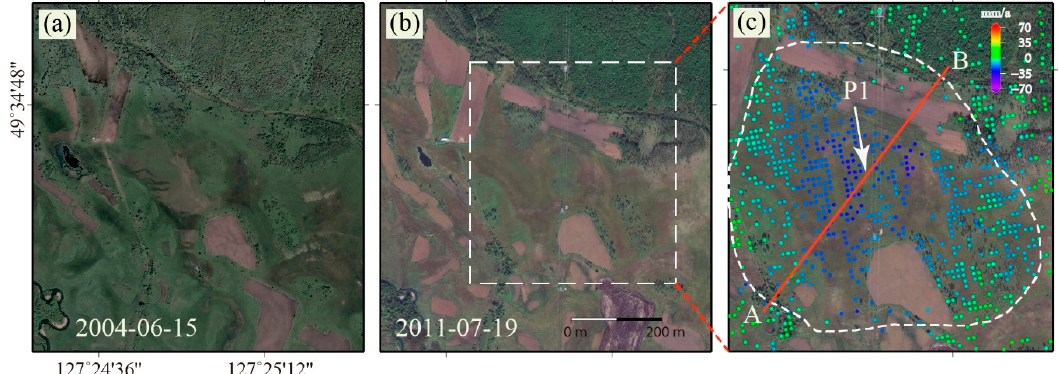
Figure 7. Optical images of selected area P1 and its deformation. ( a ) image acquired on 15 June 2004; ( b ) image acquired on 19 July 2011; ( c ) magnification of the white dashed rectangle in (c) with the deformation rate overlap; the white dashed polygon denotes the island permafrost area.